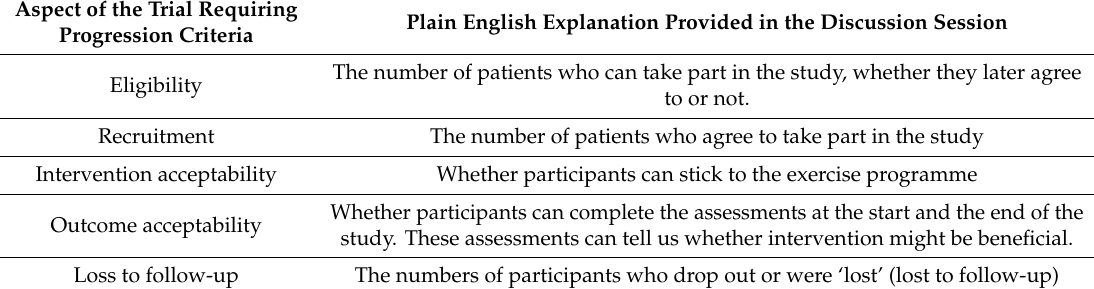
Figure 2. Example analogy to explain progression criteria and how 'stop’, ‘change’ and ‘go’ thresholds might be applied to aid decision-making. Table 2. Areas requiring progression criteria, and plain English explanations provided for each during the groups.